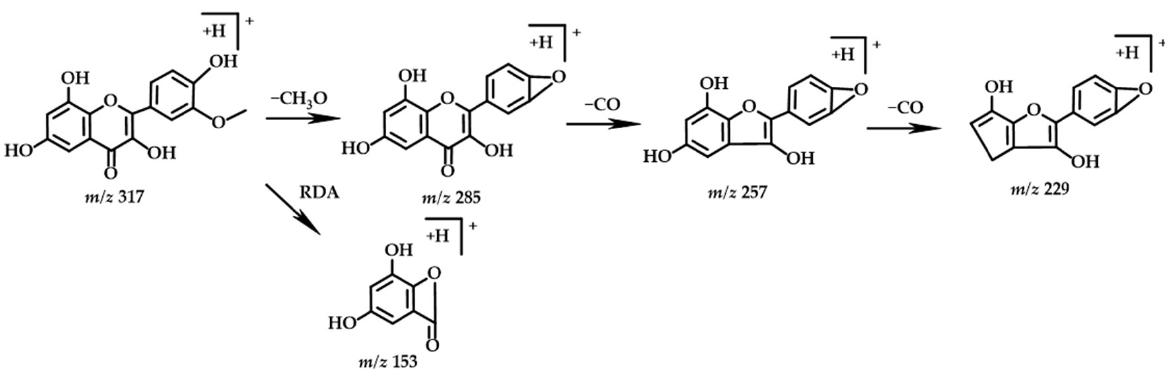
Figure 5. Chemical structure and fragmentation pathways of isorhamnetin.